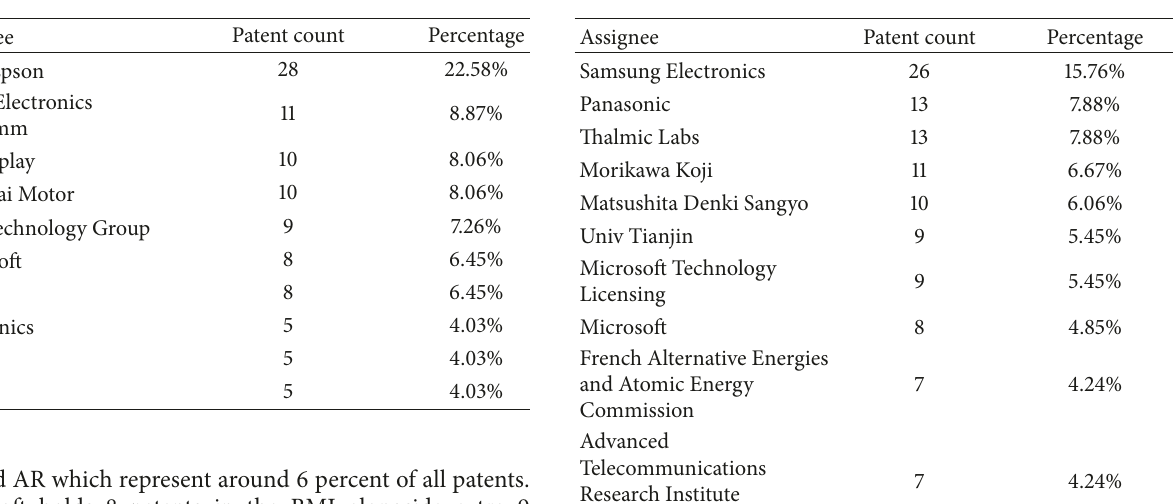
Table 4: Top assignees of VR and AR patents. Table 5: Top assignees of BMI